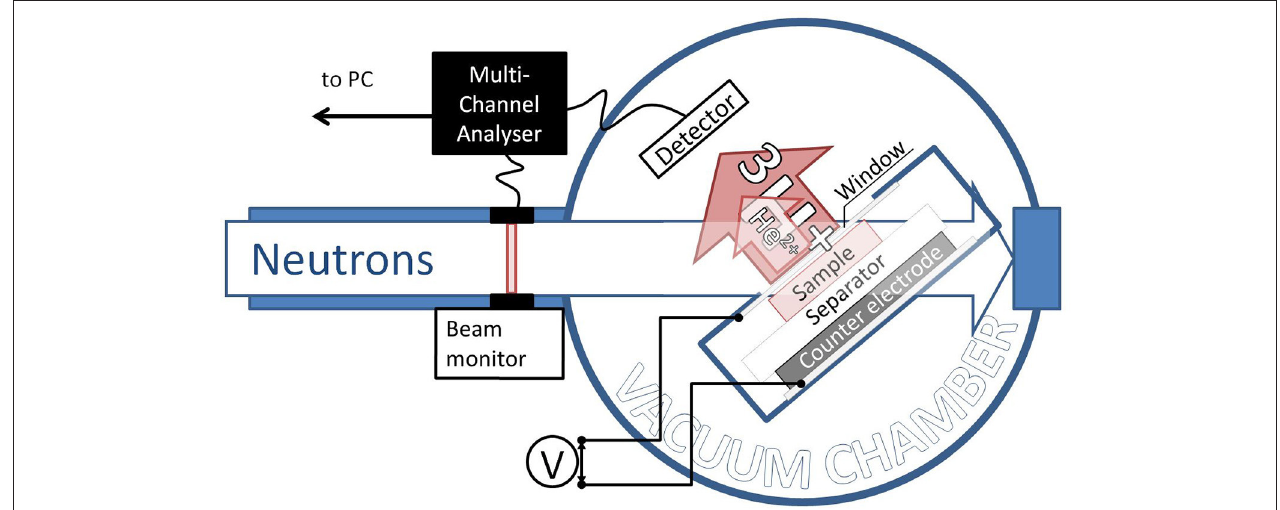
FIGURE 1 | Schematic setup of Neutron Depth